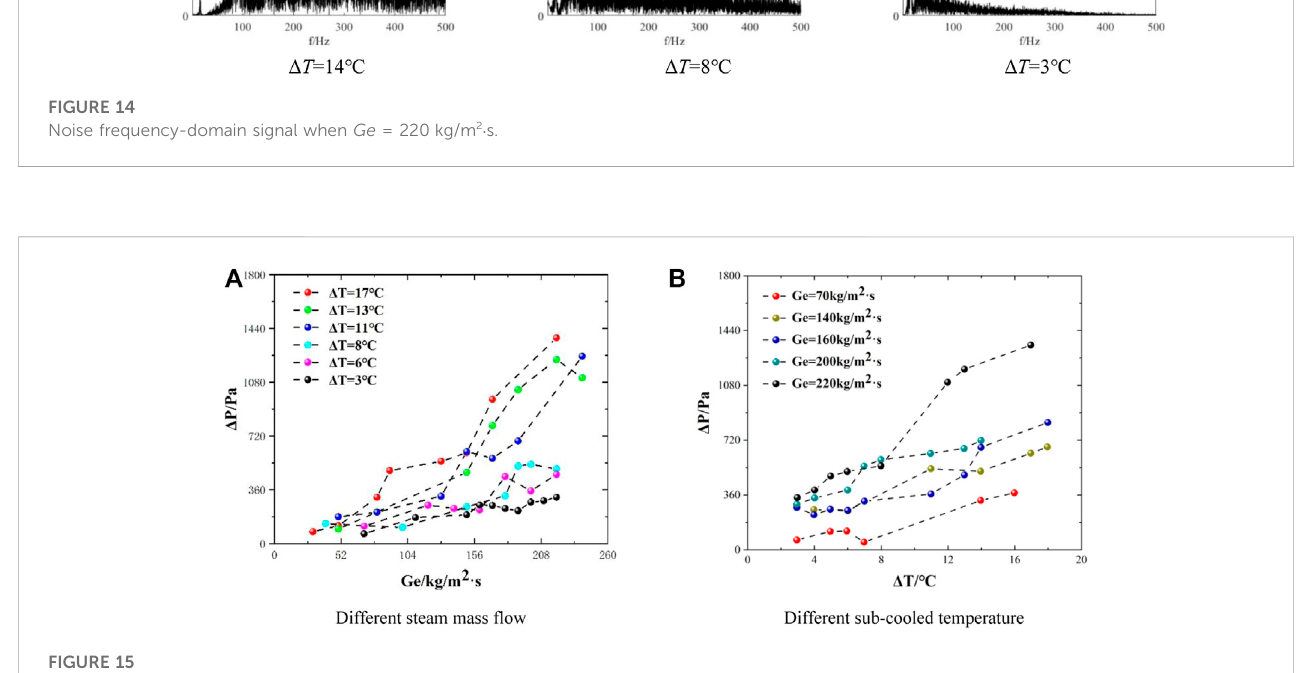
Root mean square value of